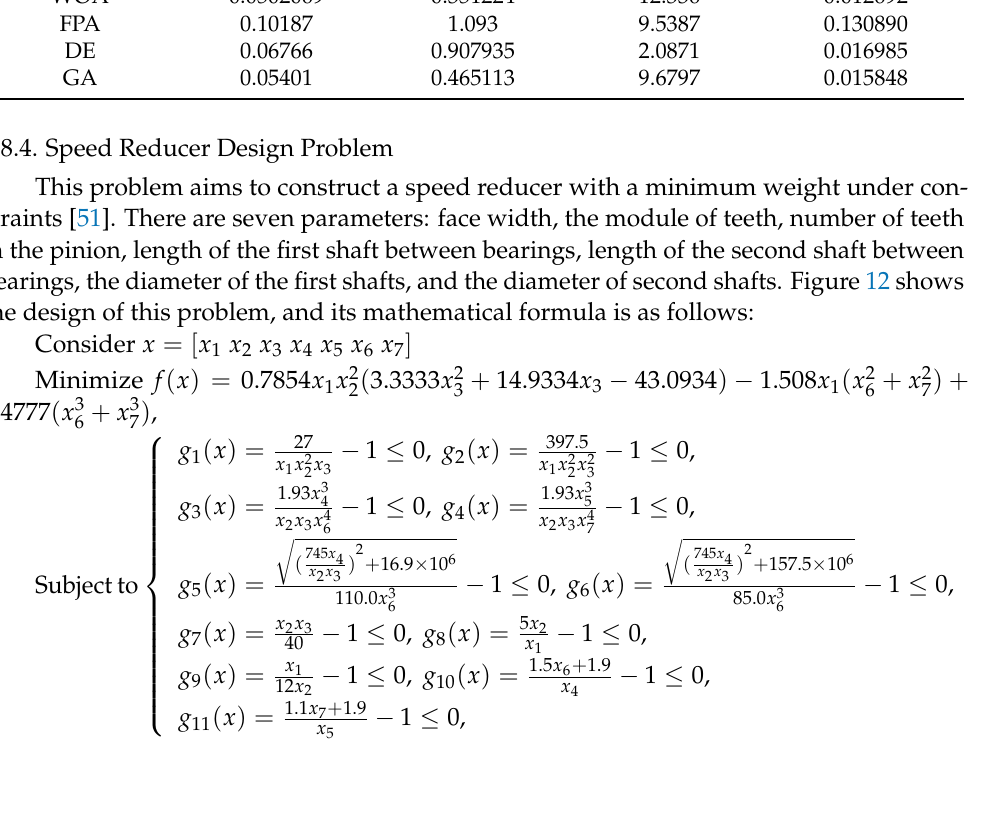
and 9.7854, respectively.